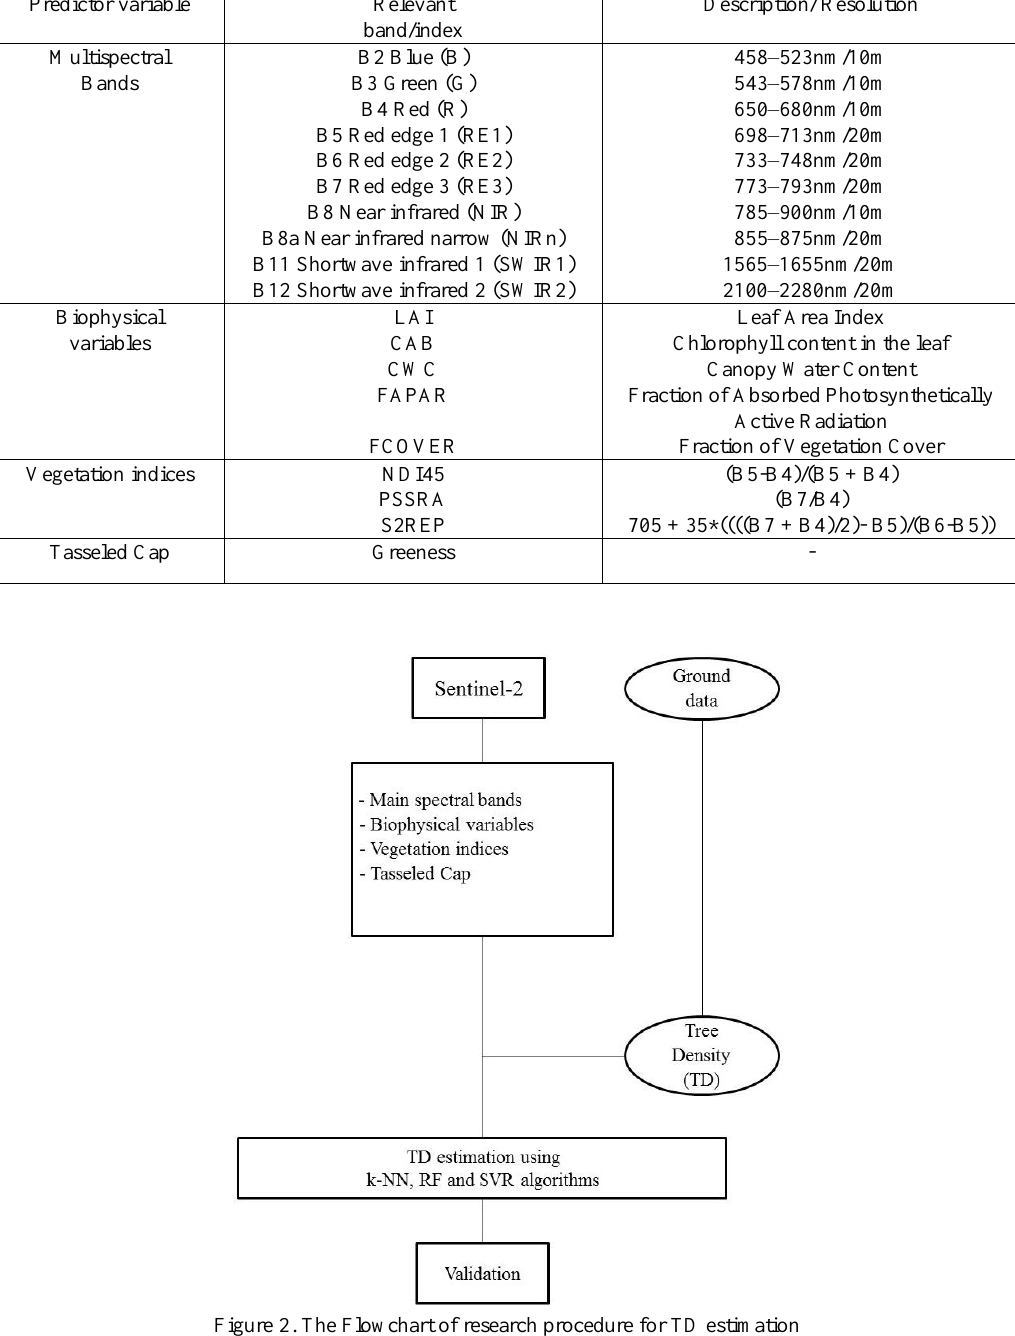
Table 1. Sentinel-2 based indices and original band used as predictors for tree density estimation